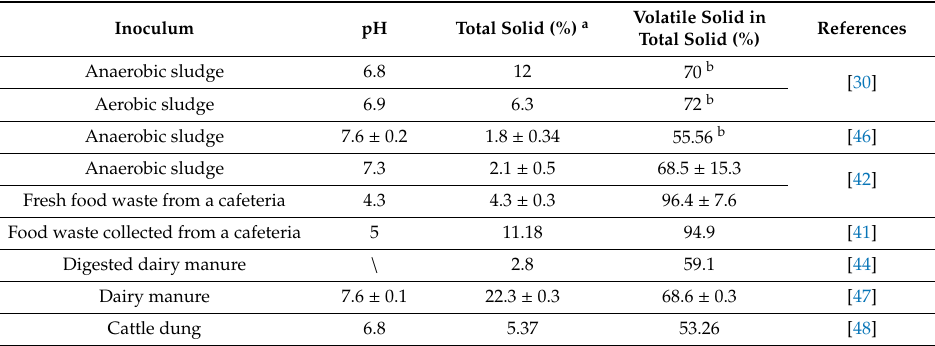
Table 2. Characteristics of mixed inoculation reported in